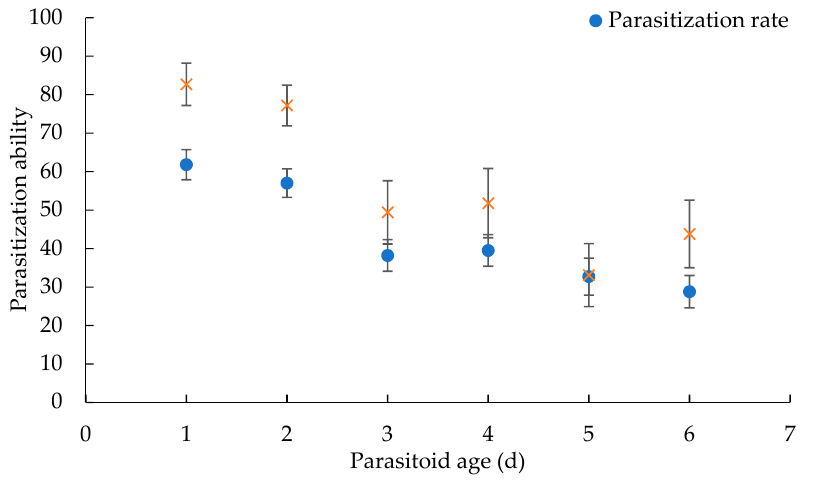
Figure 2 . Parasitization ability of S. endius on B. dorsalis at different ages. Parasitization ability means the parasitization rate and emergence percentage of S. endius .